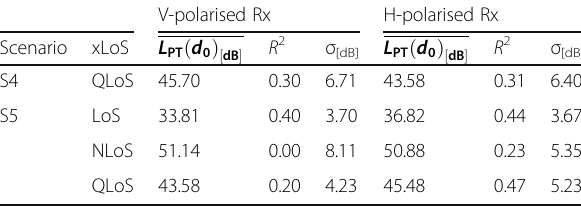
Table 8 Mean path loss parameters for V- and H-polarised Rx in scenarios S4 and S5, body B1 ( n = 1.71)